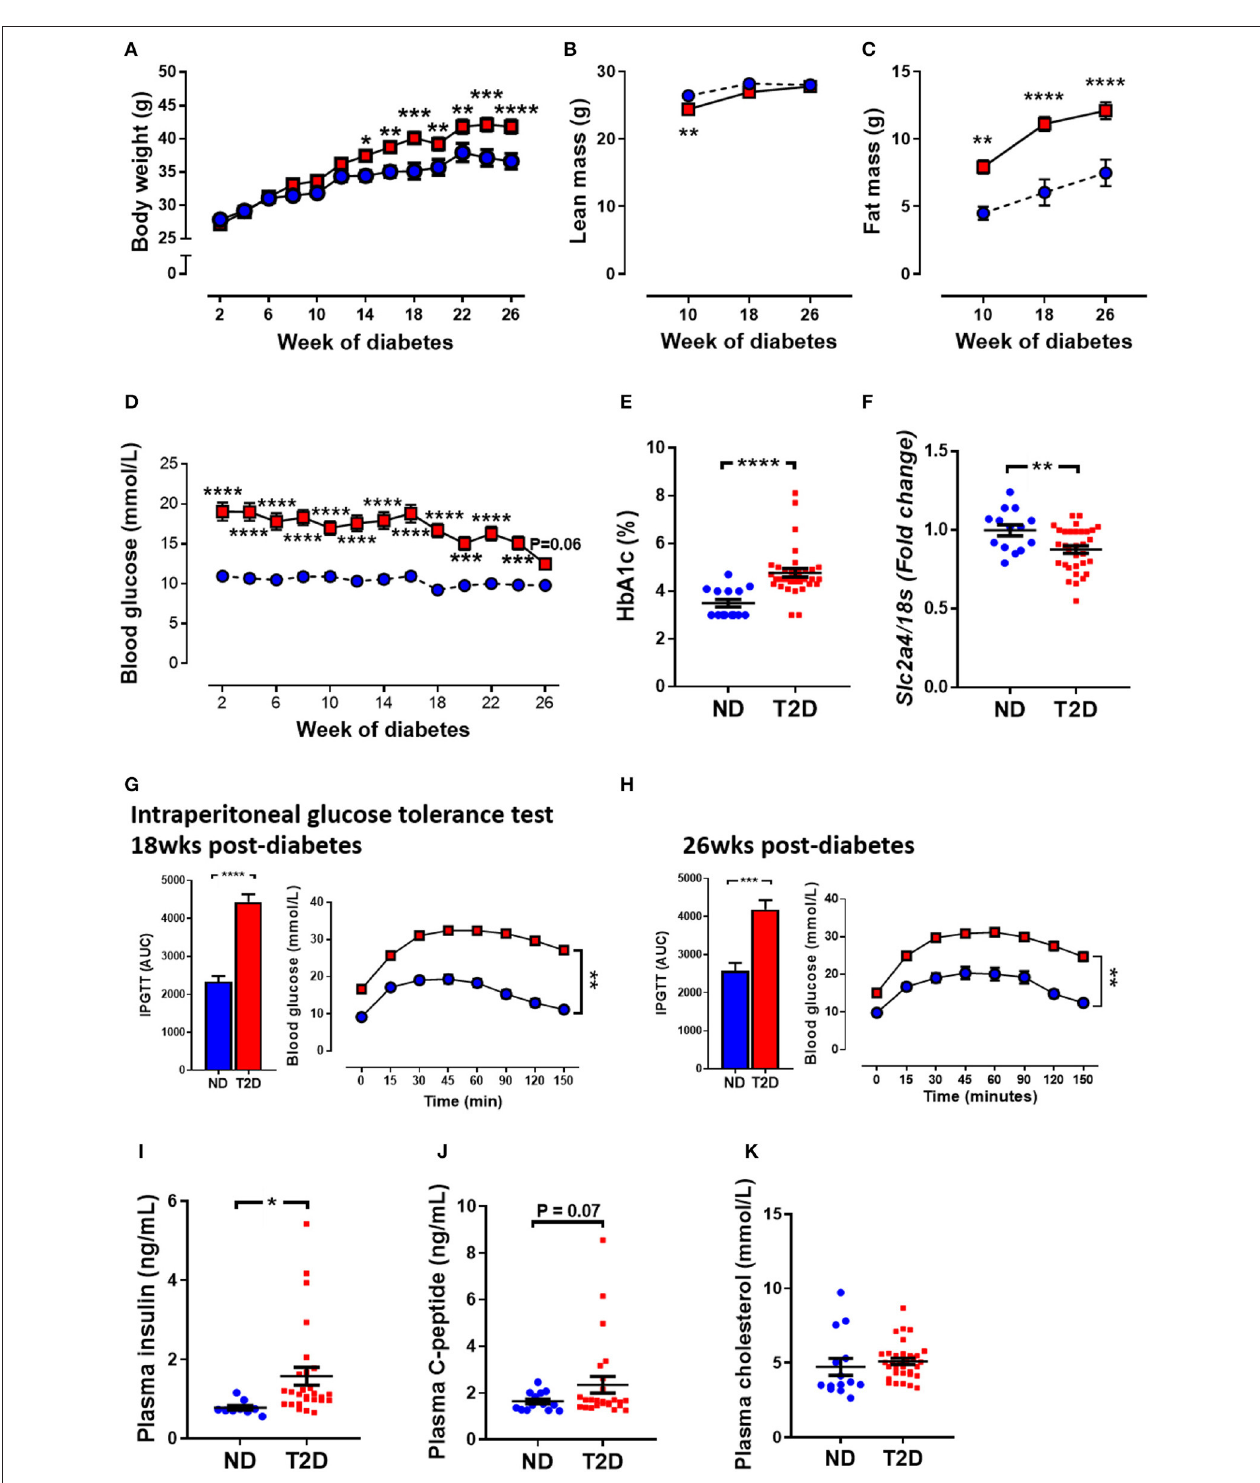
FIGURE 1 | Effect of experimental diabetes (combining low-dose STZ and high fat diet) on metabolic characteristics. (A) Body weight, (B) lean mass, (C) fat mass, (D) blood glucose, (E) percentage glycated haemoglobin (HbA1c) and (F) LV Slc2a4 gene expression (glucose transporter GLUT4). Intraperitoneal glucose tolerance test (IPGTT) at (G) 18 weeks and (H) 26 weeks. Plasma (I) insulin, (J) C-peptide levels and (K) cholesterol at 26 weeks. Data are presented as mean ± SEM. n = 9–33 per group (note individual data points). Data analysed using unpaired t -test. * P < 0.05, ** P < 0.01, *** P < 0.001, **** P < 0.0001 compared to ND. Blue circles ND; red squares T2DM. ND, non-diabetic; T2DM, type 2 diabetes; HbA1c, glycated haemoglobin; LV, left ventricle; STZ, streptozotocin, AUC, area-under-the-curve.